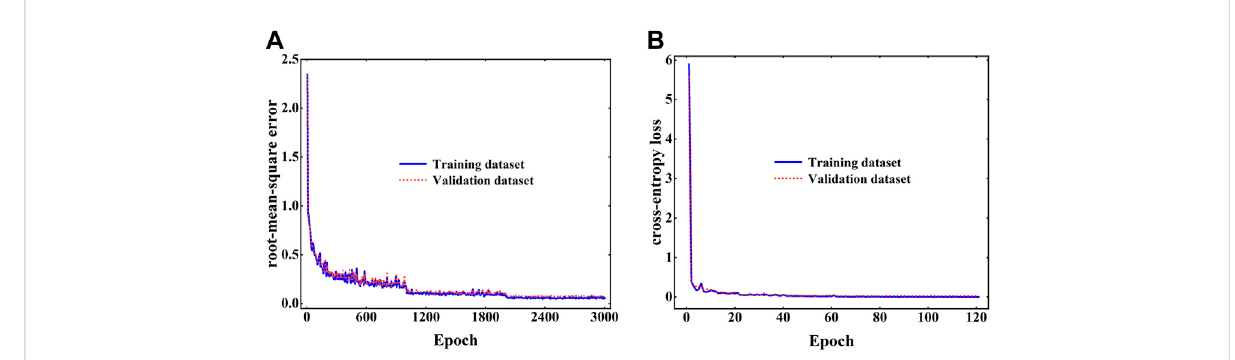
FIGURE 5 Theconvergencehistoryof (A) theroot-mean-squareerroroftheregressionneuralnetworkand (B) thecross-entropylossoftheclassi fi cation neural